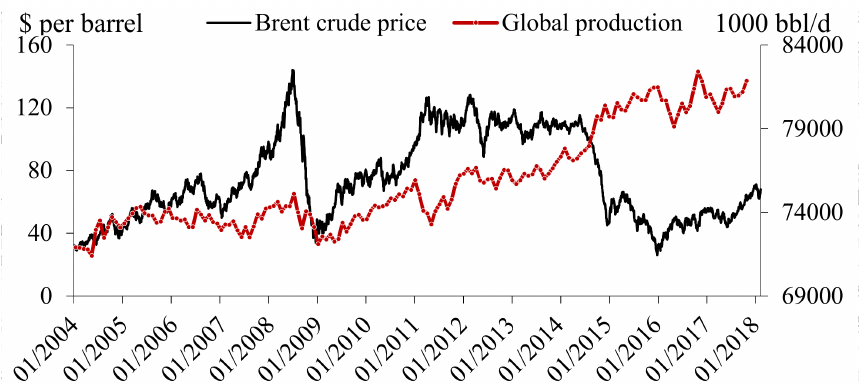
Figure 1. Daily Brent crude oil price (current U.S. dollars, $) and monthly global production (1000 billion barrels per day, bbl/d). Data source: EIA [1]. Latest price data point: 26 February